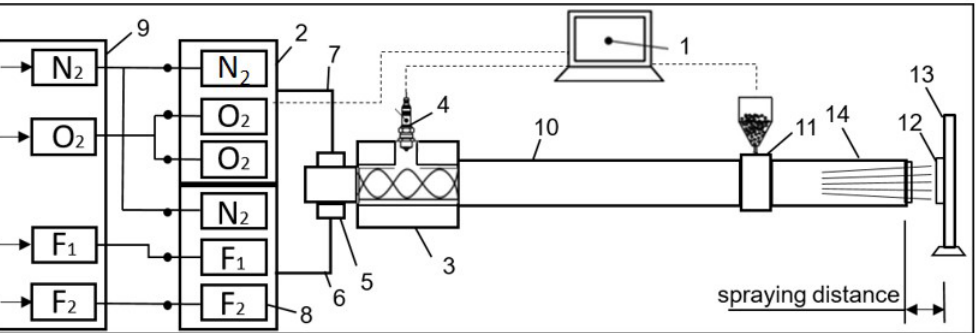
Table 1. Chemical composition of technical titanium BT1-0 (weight percent).